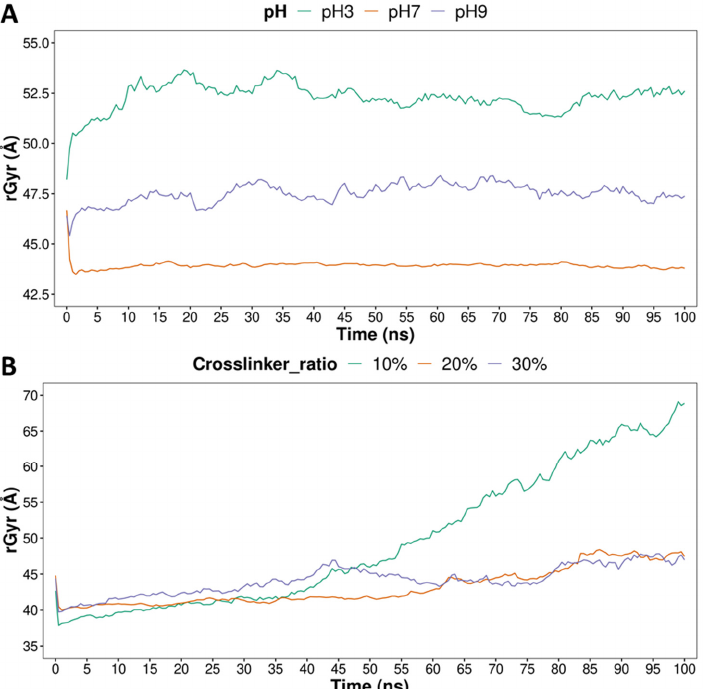
Figure 1. Radius of gyration (rGyr) of ALG-CT ( A ) and PVA-MA ( B ) hydrogels during the 100 ns of molecular dynamics simulation. A total of 3 pH values were considered for ALG-CT systems, and 3 crosslinker ratios were considered for PVA-MA systems.